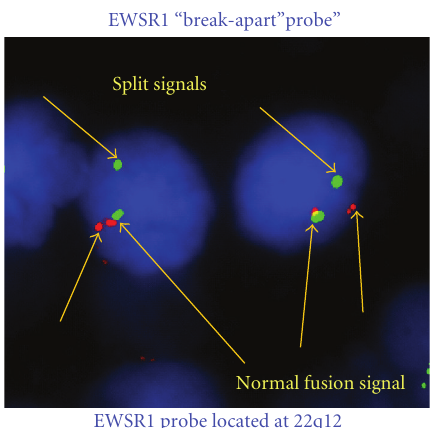
Figure 4: FISH analysis using Vysis LSI EWSR1 Dual Color Break Apart Rearrangement Probe for 22q12, showing EWS gene rearrangement EWSR1 “break-apart” probe EWSR1 probe located at 22q12 split signalsnormal fusion